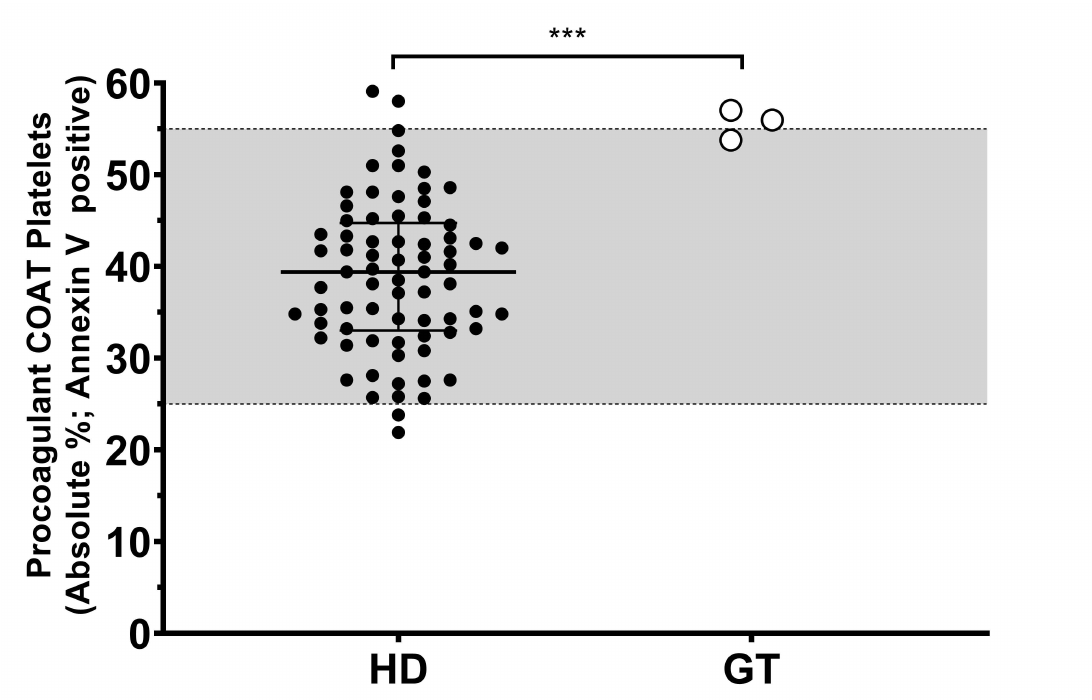
Figure 1. Procoagulant collagen-and-thrombin (COAT) platelet formation in patients with